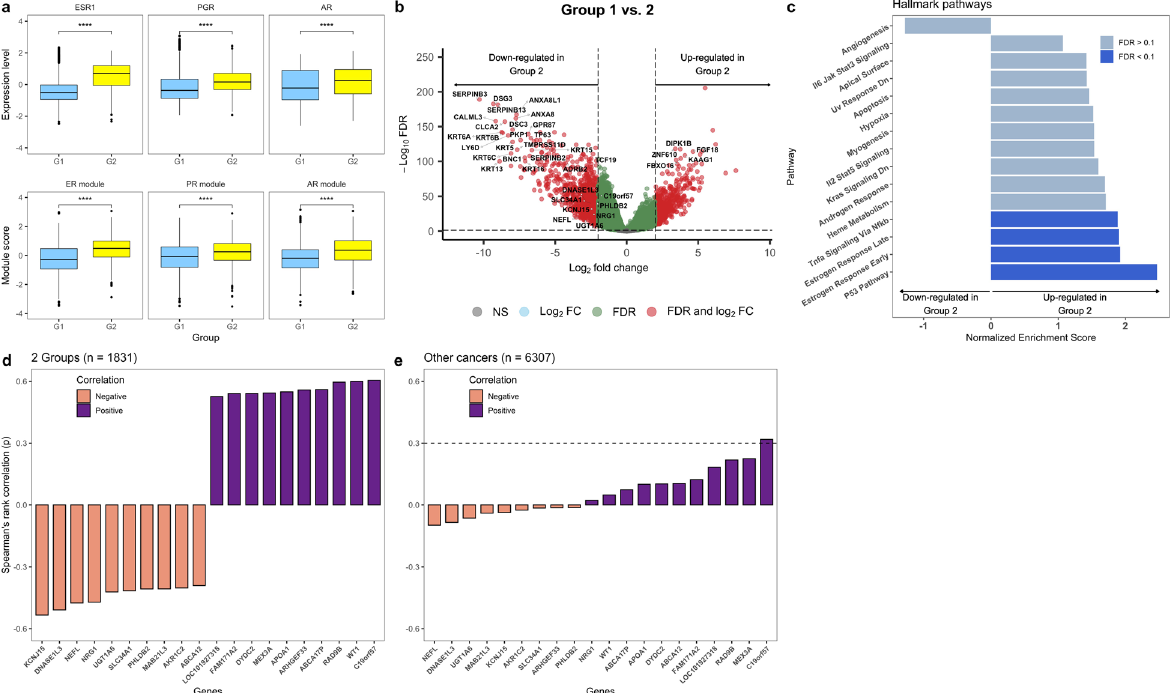
Fig. 5 Comparison of sex hormone gene modules, differentially expressed genes and signalling pathways between Groups 1 and 2. mRNA data from the tumours of Groups 1 and 2 was used to compare: a Expression of ER- α , PR and AR genes and representative gene modules. b Differential gene expression between the two groups, a volcano plot representing genes that are up- or downregulated in Group 2 relative to Group 1 is shown. c Gene set enrichment analyses (GSEA) on the basis of the differentially expressed genes in Group 2. d Barplots showing the genes with the highest Spearman ’ s rank correlation to the baseline corrected-Cell Cycle Score (BC-CCS) in the tumours of Groups 1 and 2 only ( N = 1831) and e barplots showing the genes with the highest Spearman ’ s rank correlation to BC-CCS in all other cancer types of the pan-cancer cohort (minus the tumours from Groups 1 and 2, N = 6307). p values in boxplots are based on Student ’ s T-test and, were corrected for multiple testing; **** = p < 0.0001. In the volcano plot genes with FDR < 5% and log 2 fold-change > 2 or < − 2 were considered signi fi cant. GSEA results with FDR < 10% were considered signi fi cant. Spearman ’ s rank correlation Rho was used for the correlation barplots; dashed line indicates Rho > 0.3. Within each box, horizontal lines denote median values; boxes extend from the 25 th to the 75 th percentile of each group ’ s distribution of values; vertical extending lines denote adjacent values (the most extreme values within 1.5 interquartile range of the 25 th and 75 th percentile of each